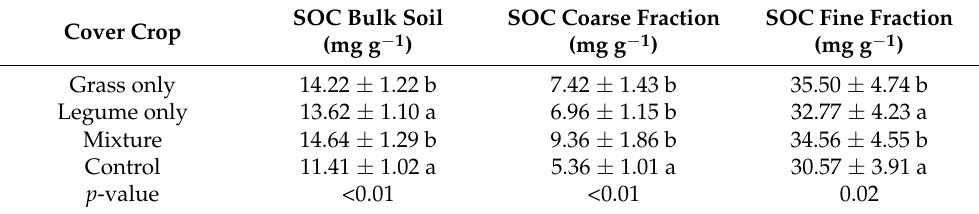
Table 5. Means ( ± standard errors) for dependent variables, bulk soil, and coarse and fine SOC fractions by treatment obtained from linear mixed effects models examining the effects of cover crop type on dependent variables at four sites (n = 16). Different lowercase letters represent significant differences between treatment groups ( α = 0.05). Authors’ elaboration based on [145]. Cover